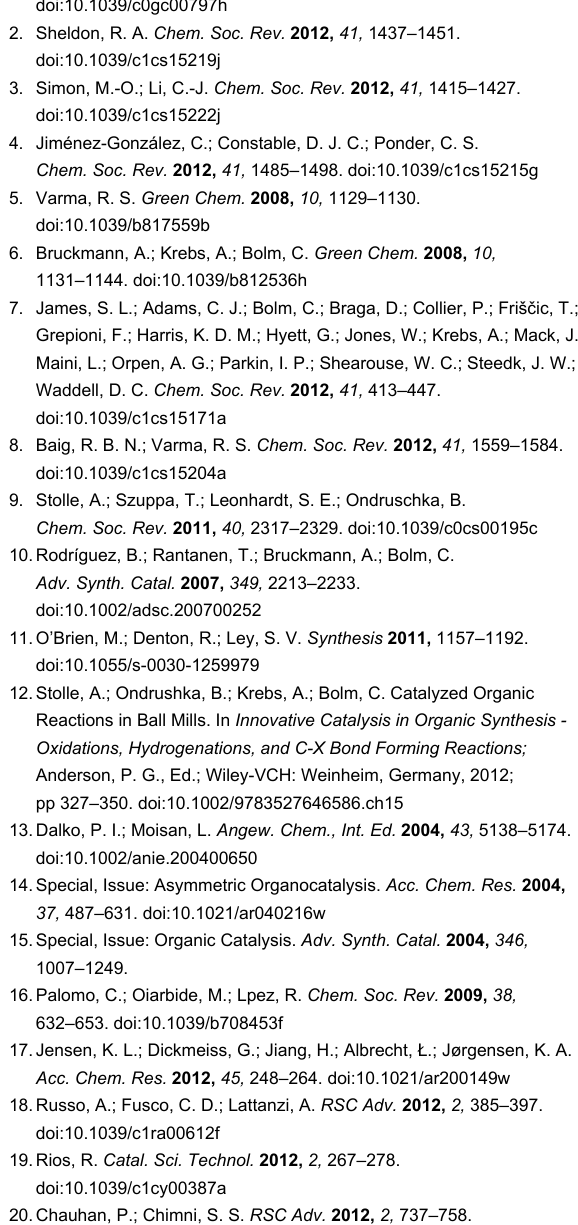
grinding methodology for the enantioselective amination of β -ketoester 13a with di-isopropylazodicarboxylate ( 25